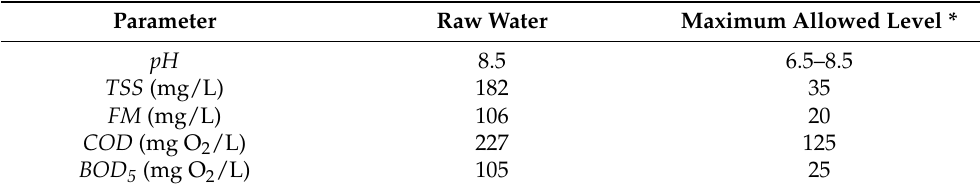
Table 5. Characteristics of the raw water used in experiments.